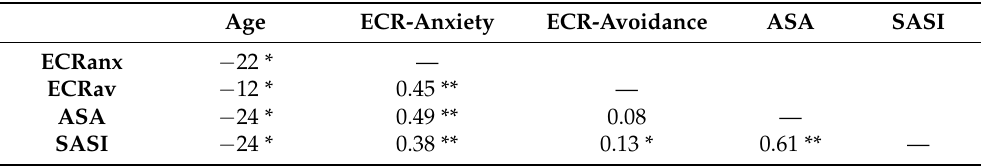
Table 2. Spearman’s Rho correlations.